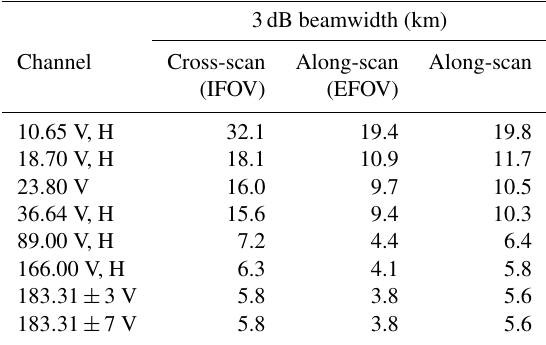
Table 1. Instantaneous (IFOV) and effective (EFOV) fields of view (native) for GMI channels. Channels are identified by their fre- quency in GHz and their polarization (V is vertical, H is horizontal). 3dB beamwidth (km) Channel Cross-scan Along-scan Along-scan